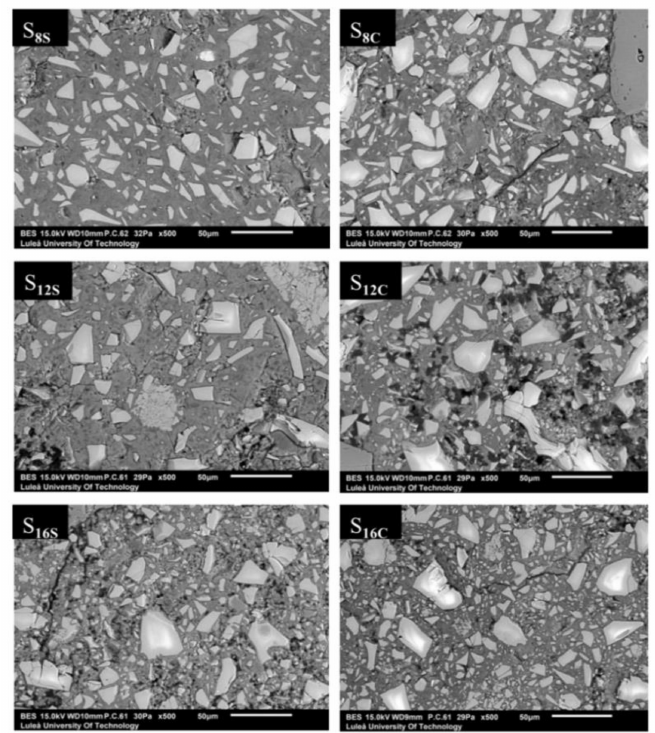
Figure 13. SEM images of the AASs mortars after 28 days of sealed curing at 21 ± 2 ◦ C and 35 ± 5% RH.